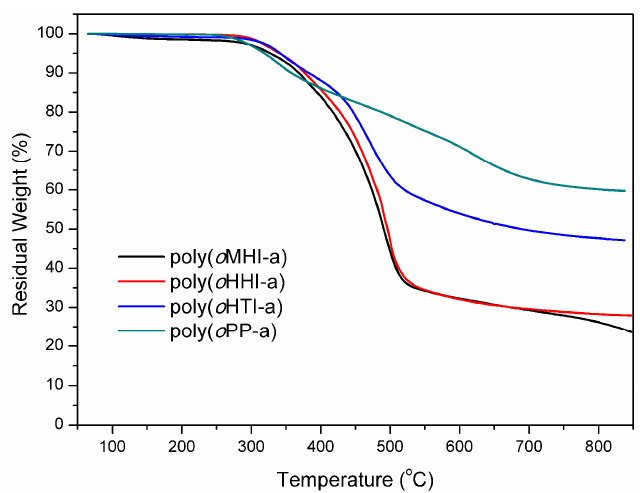
Figure 9. TGA thermograms of poly( o MHI-a), poly( o HHI-ac), poly( o HTI-a), and poly( o PP-a).